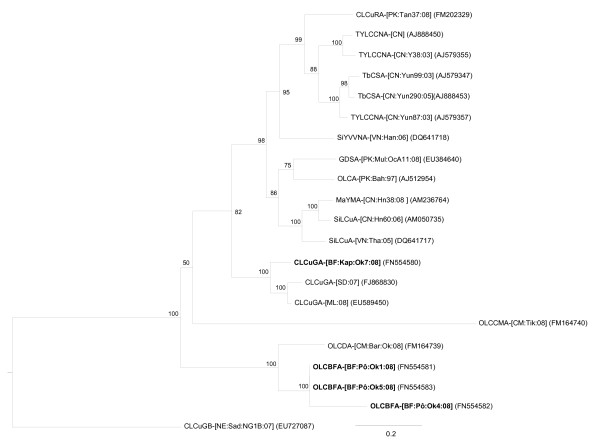
Maximum likelihood tree based on selected alphasatellite sequences. Acronyms used are as described by Mubin et al. [17]: Malvastrum yellow mosaic alphasatellite (MaYMA), Sida leaf curl alphasatellite (SiLCuA), Gossypium darwinii symptomless alphasatellite (GDSA), Okra leaf curl alphasatellite (OLCA), Cotton leaf curl Rajastan alphasatellite (CLCuRA), Tomato yellow leaf curl China alphasatellite (TYLCCNA), Tobacco curly shoot alphasatellite (TbCSA), Sida yellow vein Vietnam alphasatellite (SiYVVNA), Okra leaf curl alphasatellite (OLCA), Okra leaf curl Cameroon alphasatellite (OLCCMA) and Cotton leaf curl Gezira betasatellite (CLCuGB) (outgroup).